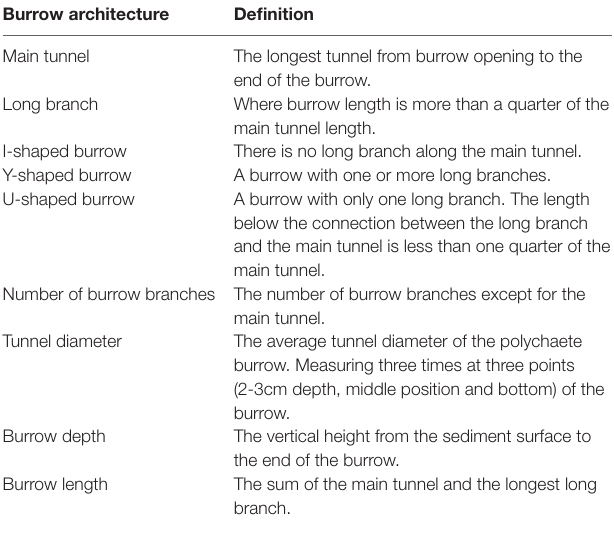
TABLE 1 | Definitions of burrow shapes and burrow architectural parameters (Lee and Koh, 1994; Davey, 1994; Kristensen and Kostka,